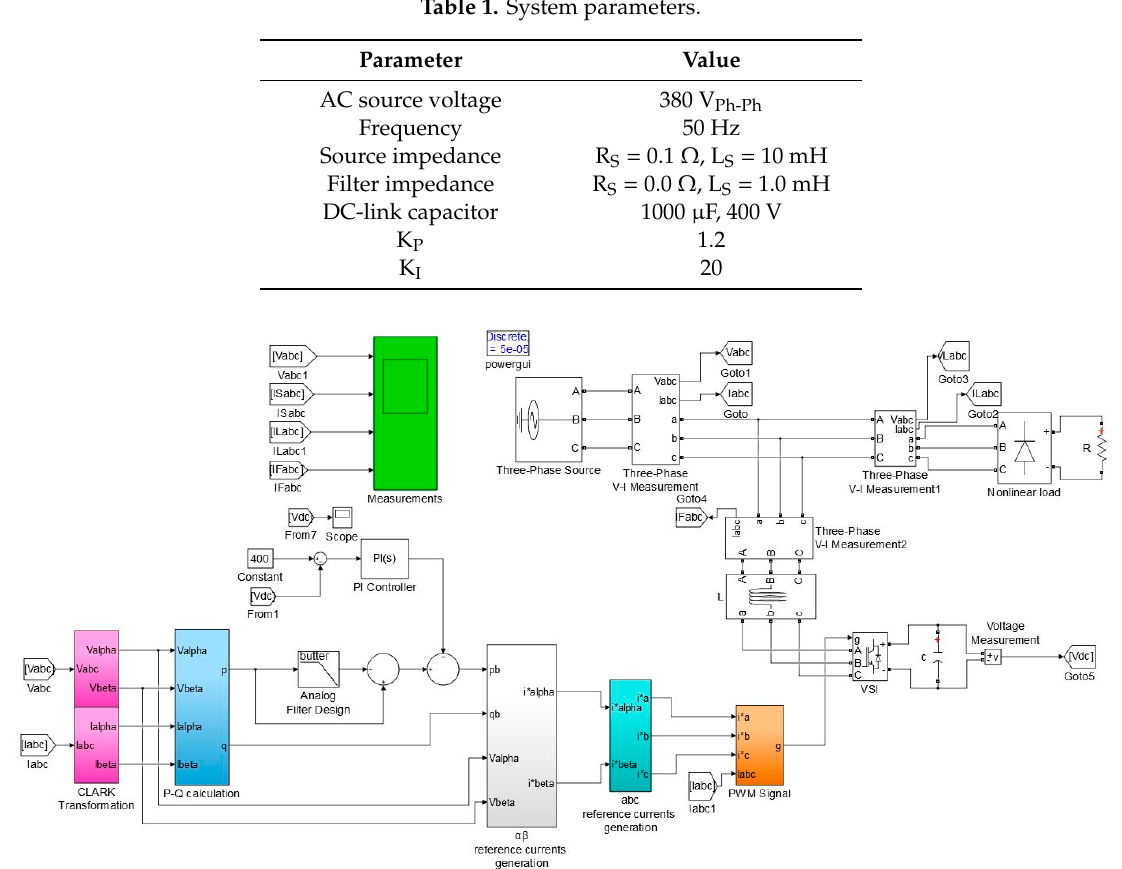
Figure 7. Simulink model of the proposed shunt active power filter (SAPF).